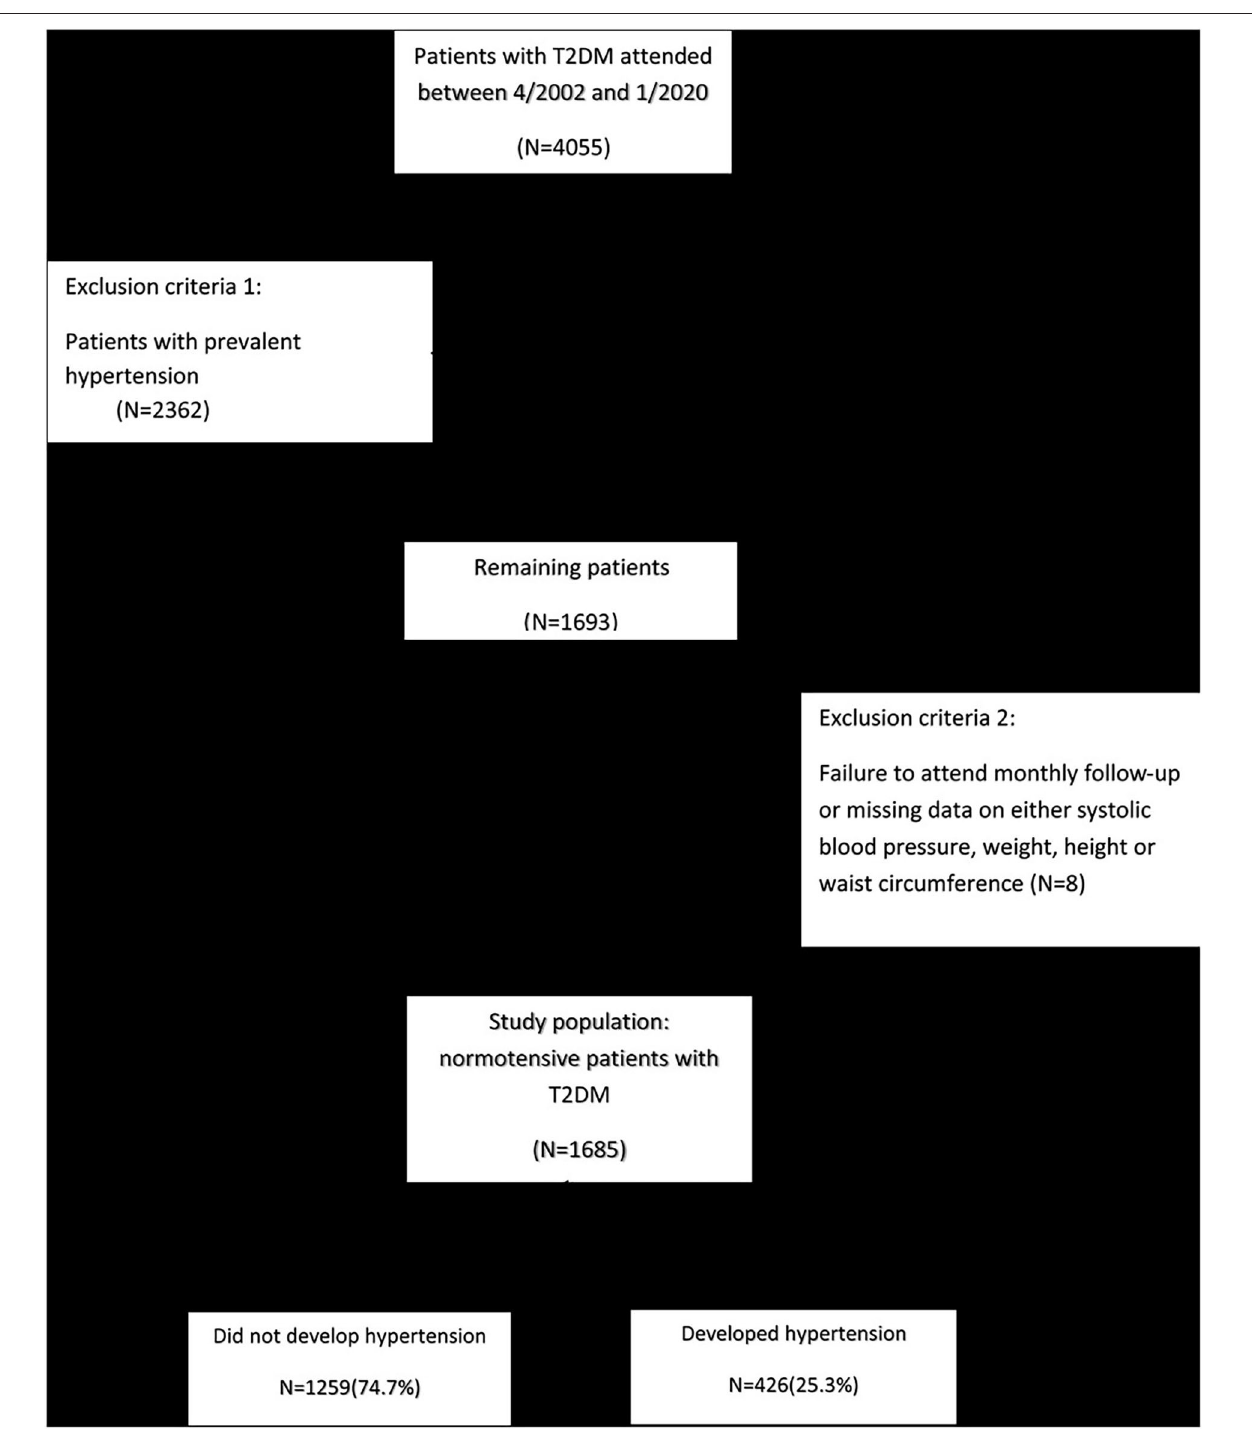
FIGURE 1 | Study population selection flow chart; T2DM = type 2 diabetes mellitus.